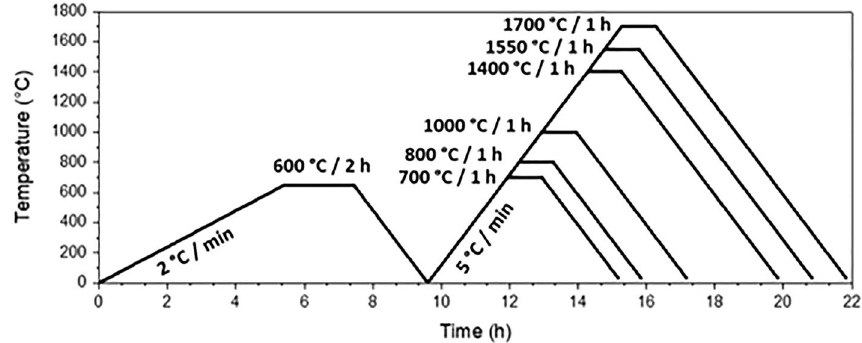
Figure 2. Thermal treatments for the extruded pastes prepared with YAG xerogel SP.